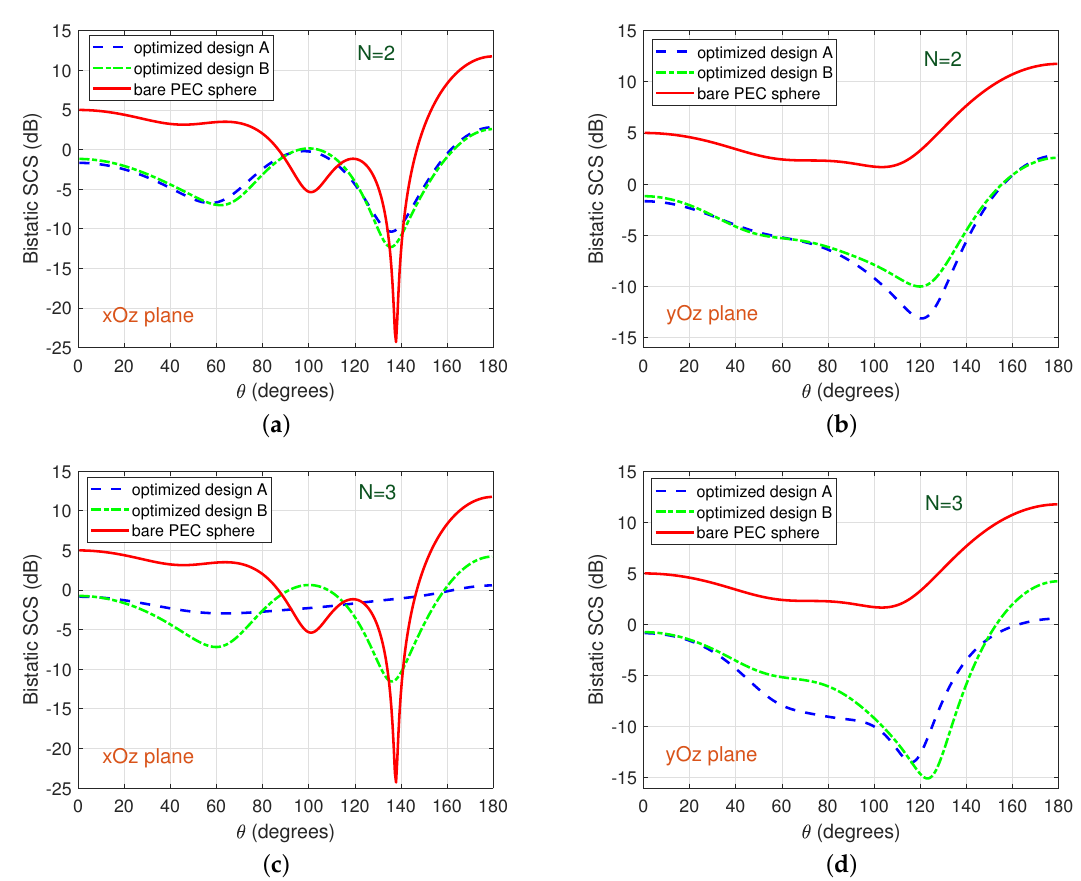
Figure 6. As in Figure 5 with ( a , b ) N = 2 and ( c , d ) N = 3, but for a dipole at b = 1.3 a 1 (spherical-wave incidence case). The values of the optimization variables for designs A and B are given in Table A4 of the Appendix A.